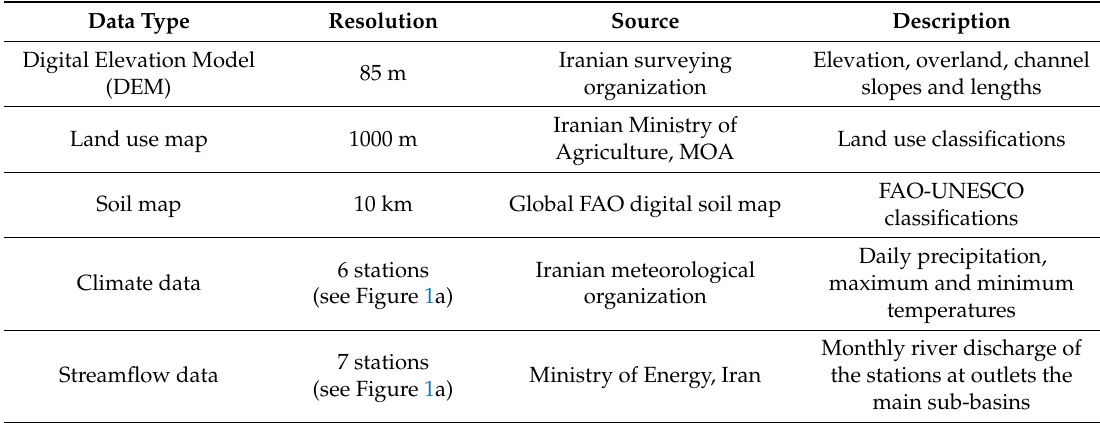
Table 1. Data and the data sources used in the hydrologic analysis of the